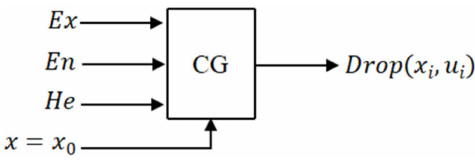
Figure 3. Conditional cloud